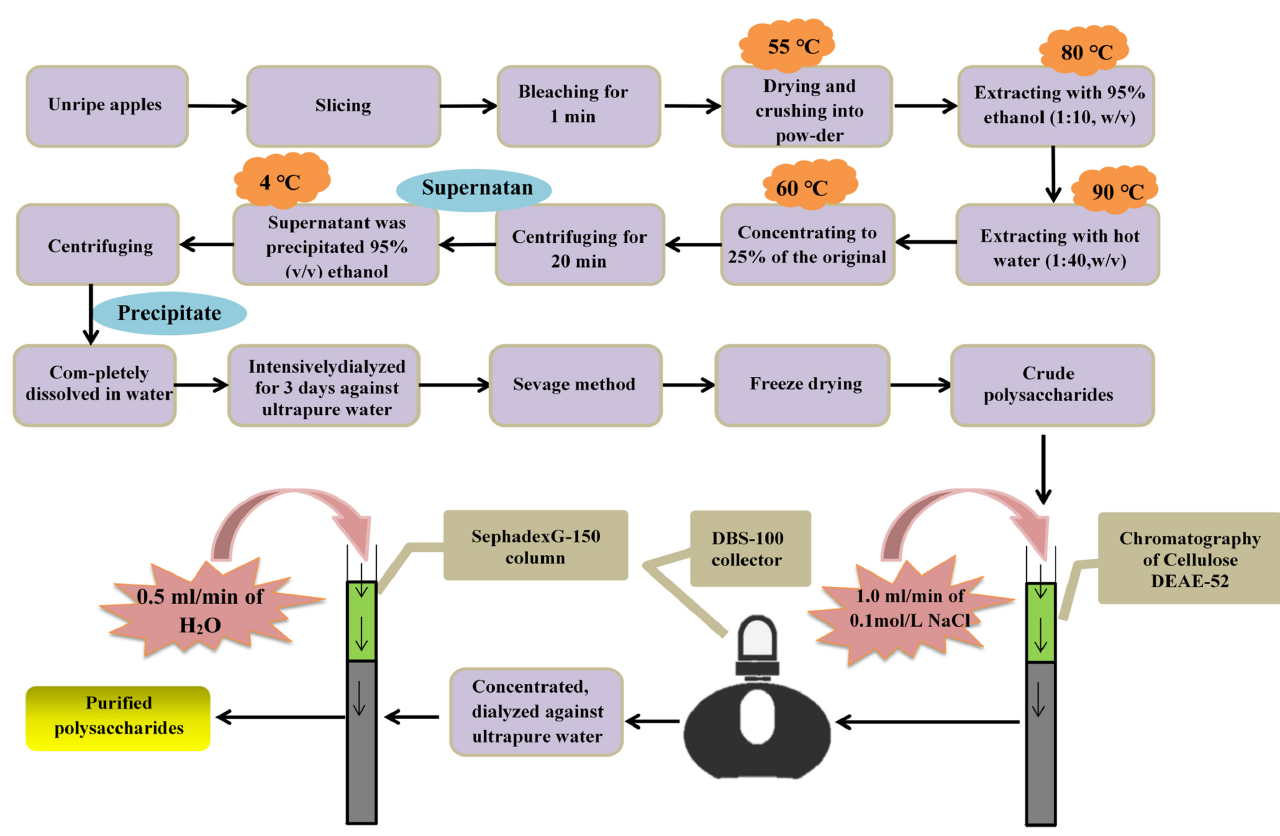
Figure 7. The entire process of the separation and purification of polysaccharides. Figure 5. The entire process of the separation and purification of